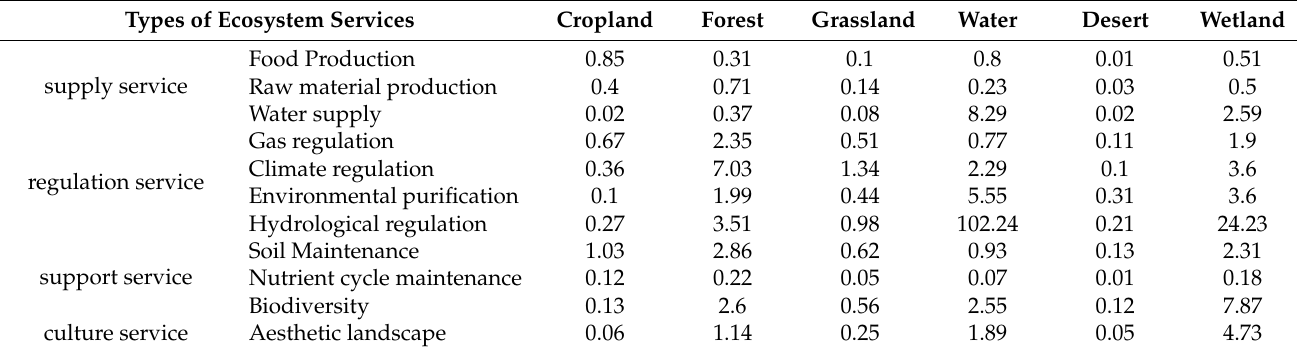
Table 1. Ecosystem service equivalent value per unit area.